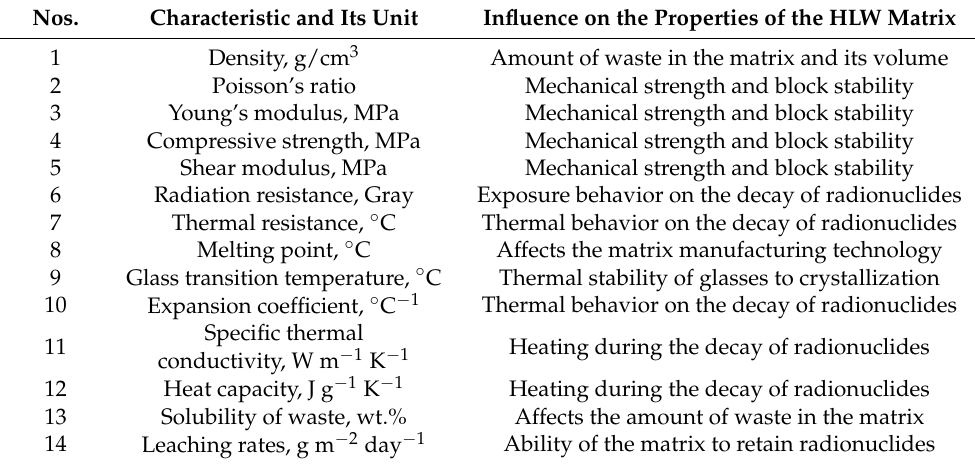
Table 2. Physical (nos. 1–12) and chemical (13–14) parameters of radionuclide matrices. Nos. Characteristic and Its Unit Influence on the Properties of the HLW Matrix 1 Density, g/cm 3 Amount of waste in the matrix and its volume 2 Poisson’s ratio Mechanical strength and block stability 3 Young’s modulus, MPa Mechanical strength and block stability 4 Compressive strength, MPa Mechanical strength and block stability 5 Shear modulus, MPa Mechanical strength and block stability 6 Radiation resistance, Gray Exposure behavior on the decay of radionuclides 7 Thermal resistance, ◦ C Thermal behavior on the decay of radionuclides 8 Melting point, ◦ C Affects the matrix manufacturing technology 9 Glass transition temperature, ◦ C Thermal stability of glasses to crystallization 10 Expansion coefficient, ◦ C − 1 Thermal behavior on the decay of radionuclides Specific thermal 11 Heating during the decay of radionuclides conductivity, W m − 1 K − 1 12 Heat capacity, J g − 1 K − 1 Heating during the decay of radionuclides 13 Solubility of waste, wt.% Affects the amount of waste in the matrix 14 Leaching rates, g m − 2 day − 1 Ability of the matrix to retain